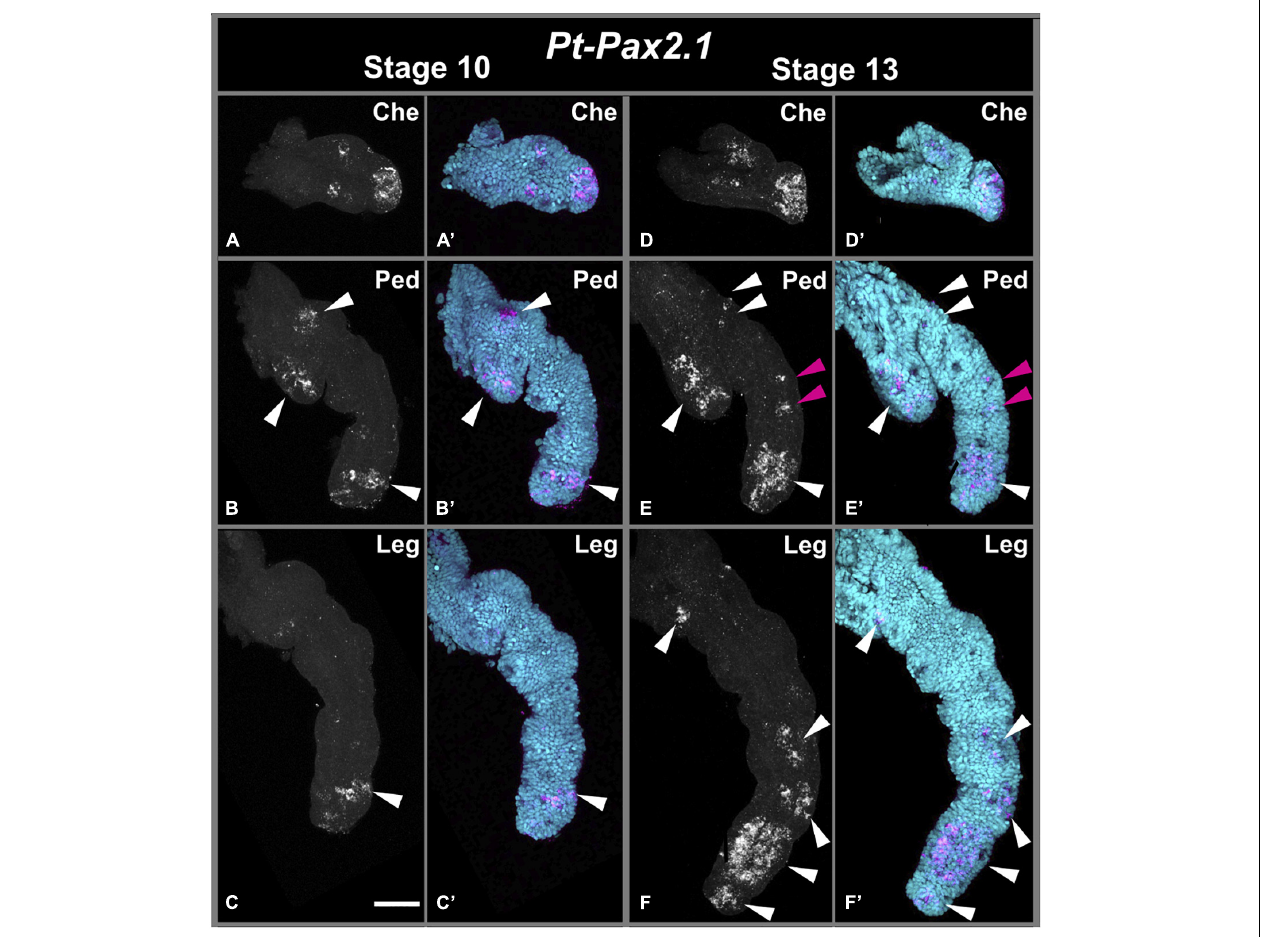
FIGURE 4 | Embryonic Pt-Pax2.1 expression in prosomal appendages. Left panels show Pt-Pax2.1 expression during brain differentiation (stage 10). Panels on the right show expression during dorsal closure (stage 13). Top row (A,A’,D,D’) shows Pt-Pax2.1 domains in the dissected chelicerae (Che). Center row (B,B’,E,E’) shows Pt-Pax2.1 expression in dissected pedipalps (Ped). Bottom row (C,C’,F,F’) shows expression in dissected walking leg(s) (Leg). White arrowheads indicate expression clusters throughout development, and magenta arrowheads mark newly emerged pedipalpal medial expression domains. Early Pt-Pax2.1 expression in the chelicera is present as two medial spots and a distal domain. While the distal domain stays in later stages, the two medial spots slightly broaden and diffuse. In the pedipalp Pt-Pax2.1 expression starts in three patches, one in the gnathendite, one in the proximal ventral side and one domain in the distal tip, similar to the expression in the walking leg. Later the expression in the gnathendite and distal tip broadens, the proximal patch splits and two spot-like expression domains arise in the medial part of the pedipalp. In the walking leg expression starts in the distal leg region, which broadens during development. Later Pt-Pax2.1 expression covers all distal leg segments both as large domain but also spot-like patterns. In the proximal part a spot-like domain appears. Cyan is nuclear DAPI staining; magenta is Pt-Pax2.1 specific expression detected with FAST RED. Scale bar represents 50 µ